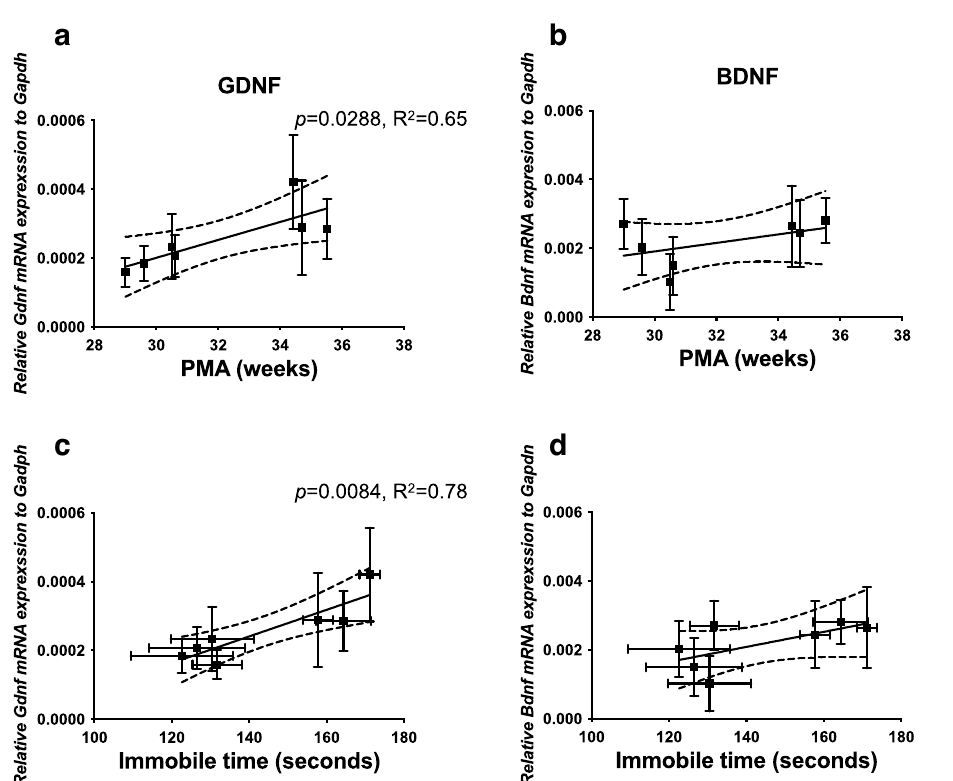
Figure 8. PMA-depended neurotrophic factor GDNF, but not BDNF, was associated with improved fear retention. Gene expression of GDNF levels examined by RT-PCR were significantly increased with increasing PMA ( a ). BDNF levels were not changed with PMA ( b ). Data are expressed as the ratio of the mRNA expression of the gene of interest relative to GAPDH mRNA expression. Data are presented as mean ± SEM and n = 5–13. Increased GDNF ( c ), but not BDNF ( d ), was significantly associated with increased immobile time in the second half of the cued testing in fear conditioning